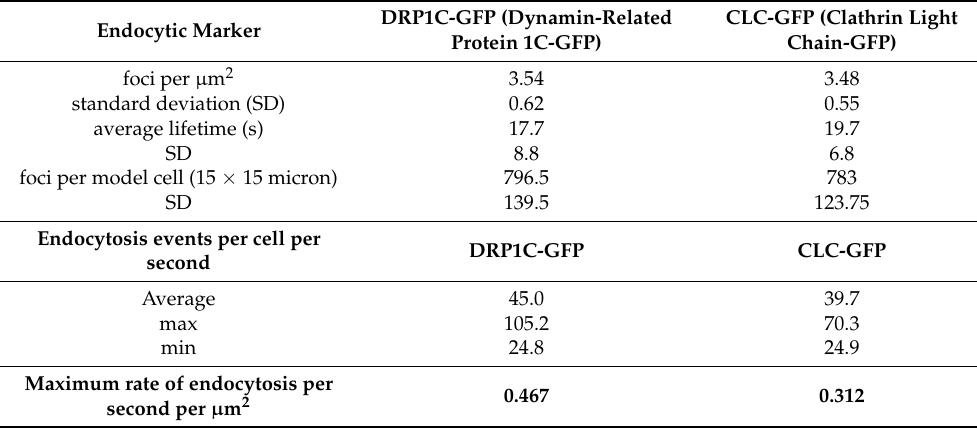
Figure 3. PIN2 translational fusion to Green Fluorescent Protein (PIN2-GFP) density measured by 3D structured illumination microscopy (SIM). ( a ) Example max projection of a 3D SIM image of the lateral membrane of root epidermal cells; ( b ) Left panel; the magnified yellow rectangle in ( a ). Middle panel; the image is made binary and subjected to watershed segmentation. Right panel; pink circles denote detected PIN2-GFP spots. Scale bars; ( a ), 5 µ m, ( b ), 2 µ m. Table 4. Calculation of rate of endocytosis (based on values from